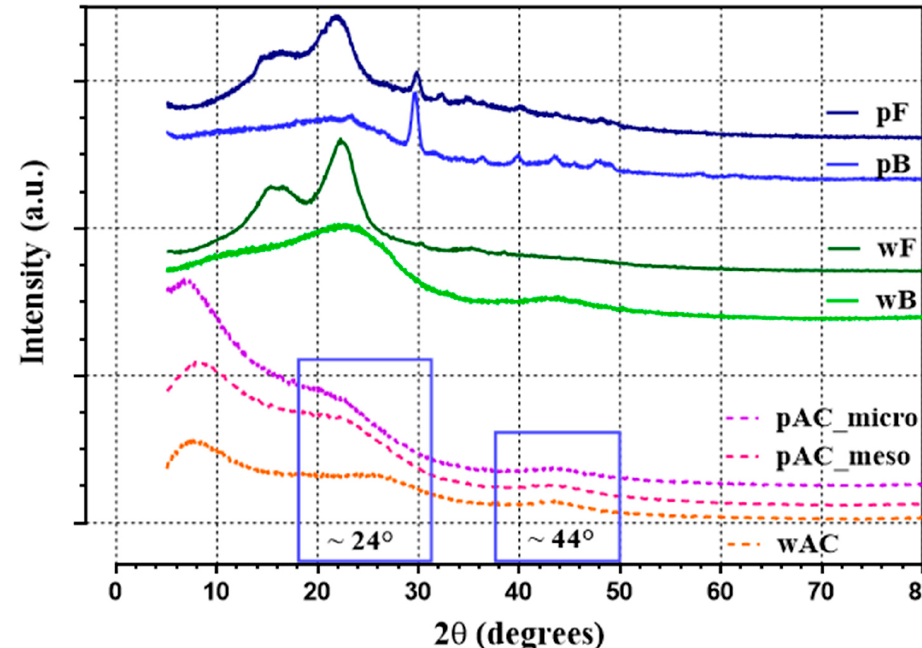
Figure 1. X-ray diffraction patterns of fresh biomasses (pF and wF), biochars (pB and wB), and activated carbons (pAC_meso, pAC_micro, and wAC). The patterns of pF, pB, wB, and wAC were published in Ref. [10].